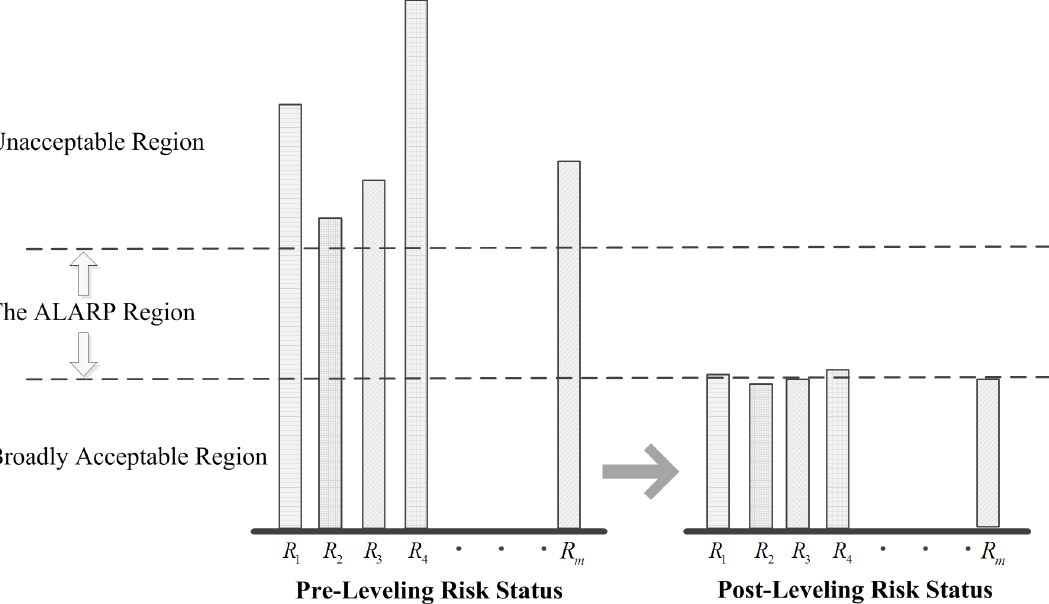
Figure 8. Risk Leveling - A Conceptual